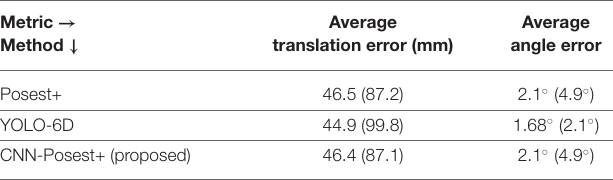
FIGURE 7 | Accuracy A ( t ) as a function of different thresholds t ∈ [1,10] on the Muselearn dataset. TABLE 2 | Average translation and angular error (and std dev) of the three methods for the Muselearn dataset.